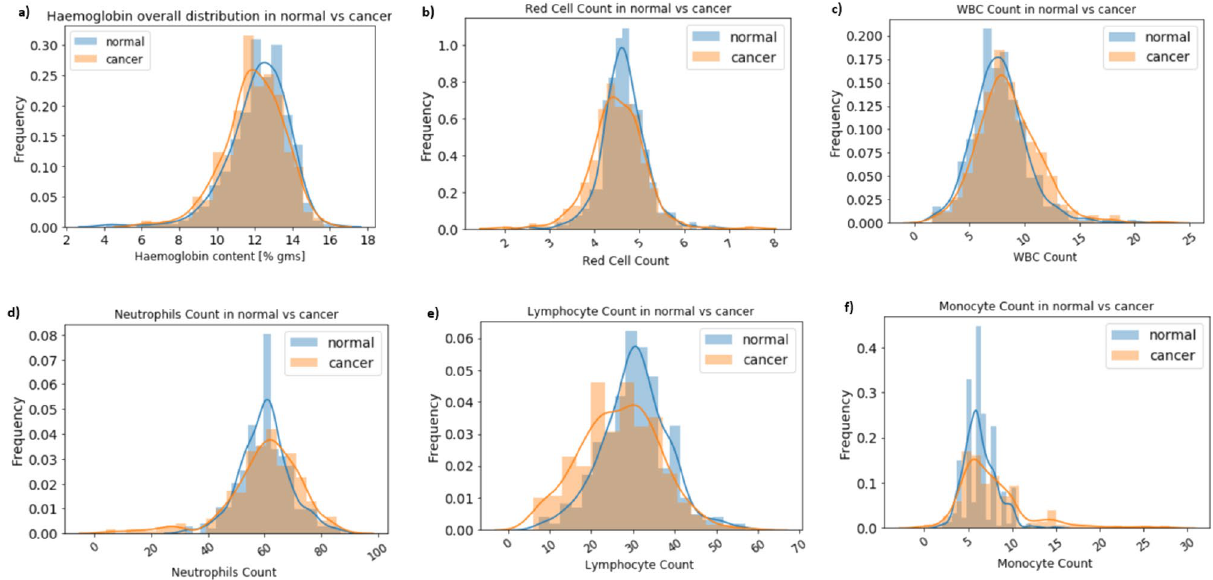
Figure 4. Overall distribution of haematological parameters between normal and cancer subjects. Histogram showing ( a ) haemoglobin content, ( b ) red cell count, ( c ) white blood cells, ( d ) neutrophils, ( e ) lymphocytes, and ( f ) monocyte counts. Here, frequency on the Y-axis represents the number of times a particular value occurred between normal and cancer subjects (no. of times repeated/total no. of. The overall distribution of haematological parameters in breast cancer patients. Blood is the main carrier for tumor cell dissemination and cancer metastasis. Based on text mining data (Supplementary Table 2) we extracted blood profile data from metastatic breast cancer patients. Blood profile data consist of Haemoglobin content, Red cells, White Blood cells, Neutrophils, Lymphocyte, and Monocyte counts. Moreover, blood profile data from normal female subjects were retrieved as a part of regular check-ups and tabulated in a single excel sheet. An equal number (376 + 376) of cancer and normal subjects were compared to identify the overall distribution of haematological parameters (Supplementary Table 4). Results showed that haemoglo- bin content, WBC, Lymphocyte, and Monocyte showed differential distribution between normal and cancer patients. Low Hb content, high WBC, Lymphocyte, and Monocyte are observed in cancer patients as compared to control (Fig. 4). Among all, red cell and monocyte count is increased and show a clear distinguishing pattern in cancer patients. The overall mean difference for Hb content in a cancer patient is 11.95 (12.19) as compared to normal with a p-value less than 0.05 (0.038). Similarly, for RBC 4.511 (4.643) with p value of 0.0007, for WBC 8.554 (7.724) with p-value of 0.0001, for Neutrophils 60.263 (60.194) with p value of 0.93, for Lymphocyte 26.75(30.42) with p value of 0.0 and for Monocyte 7.76 (6.36) with p-value of 0.0. Except for Neutrophils p value for all the Haematological parameters is significant. Overall, it suggests that Lymphocytes and monocytes are showing a distinguishing pattern between normal and cancer subjects. Overall it suggest that blood profile data can be used to distinguish breast cancer subjects as compared to normal subjects.